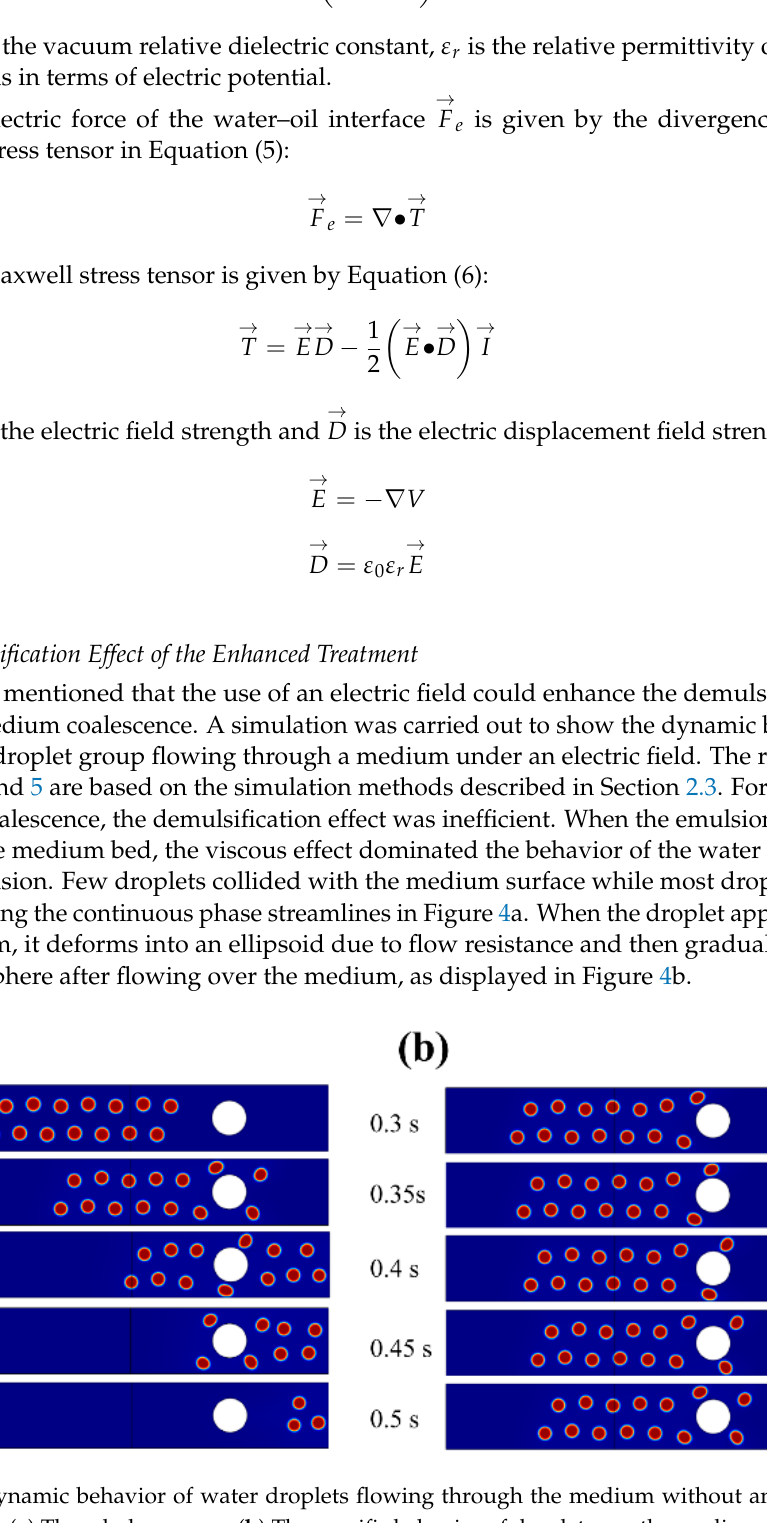
droplets to overcome the viscous effect (Figure 5a). The droplet was forced to travel back and forth between the electrodes when a sufficient electric field was applied, contributing to the escape from continuous phase streamlines. At 0.70–1.05 s, a water droplet collided, adhered and spread rapidly on the medium surface. Subsequently, the adhered droplet continued to move along the surface by fluid drag force (Figure 5b). At 1.05–1.10 s, another droplet broke away from continuous phase streamlines and collided with the medium just like the previous one. At 1.10–1.20 s, the two adhered droplets formed a bridge joint and eventually merged into a bigger one. Furthermore, the somewhat big merged droplet with a large surface area could capture another fine droplet directly, improving the de- mulsification effect (Figure 5c).